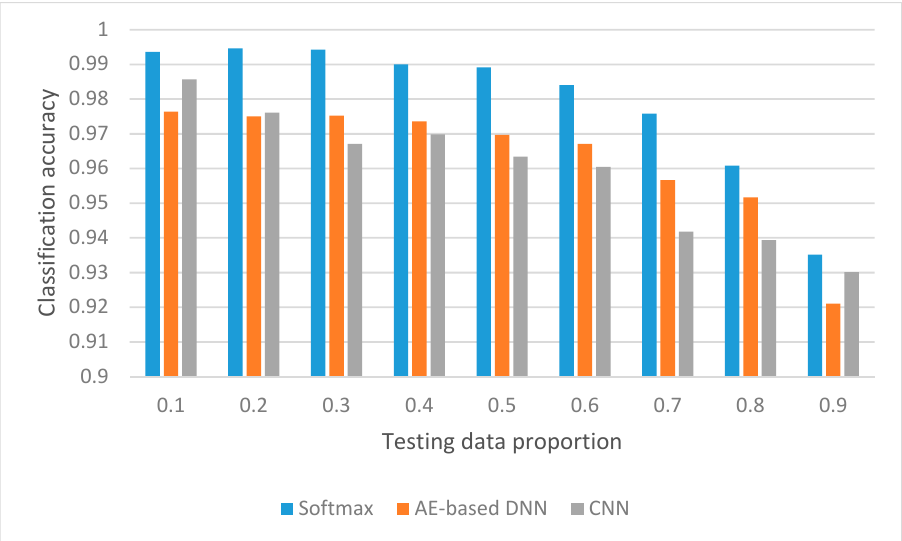
Figure 10. Comparison of classification accuracy for the three methods. Sensors 2020 , 20 , x FOR PEER REVIEW